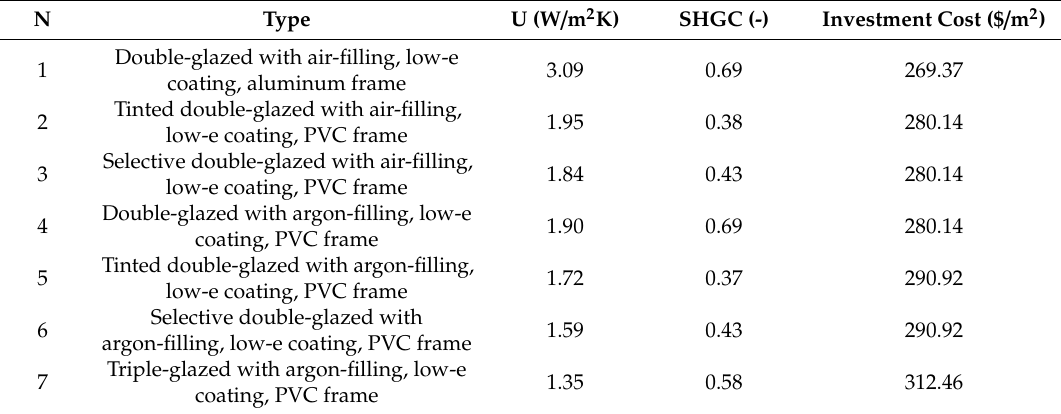
Table 6. Di ff erent types of windows and their parameters and investment costs.